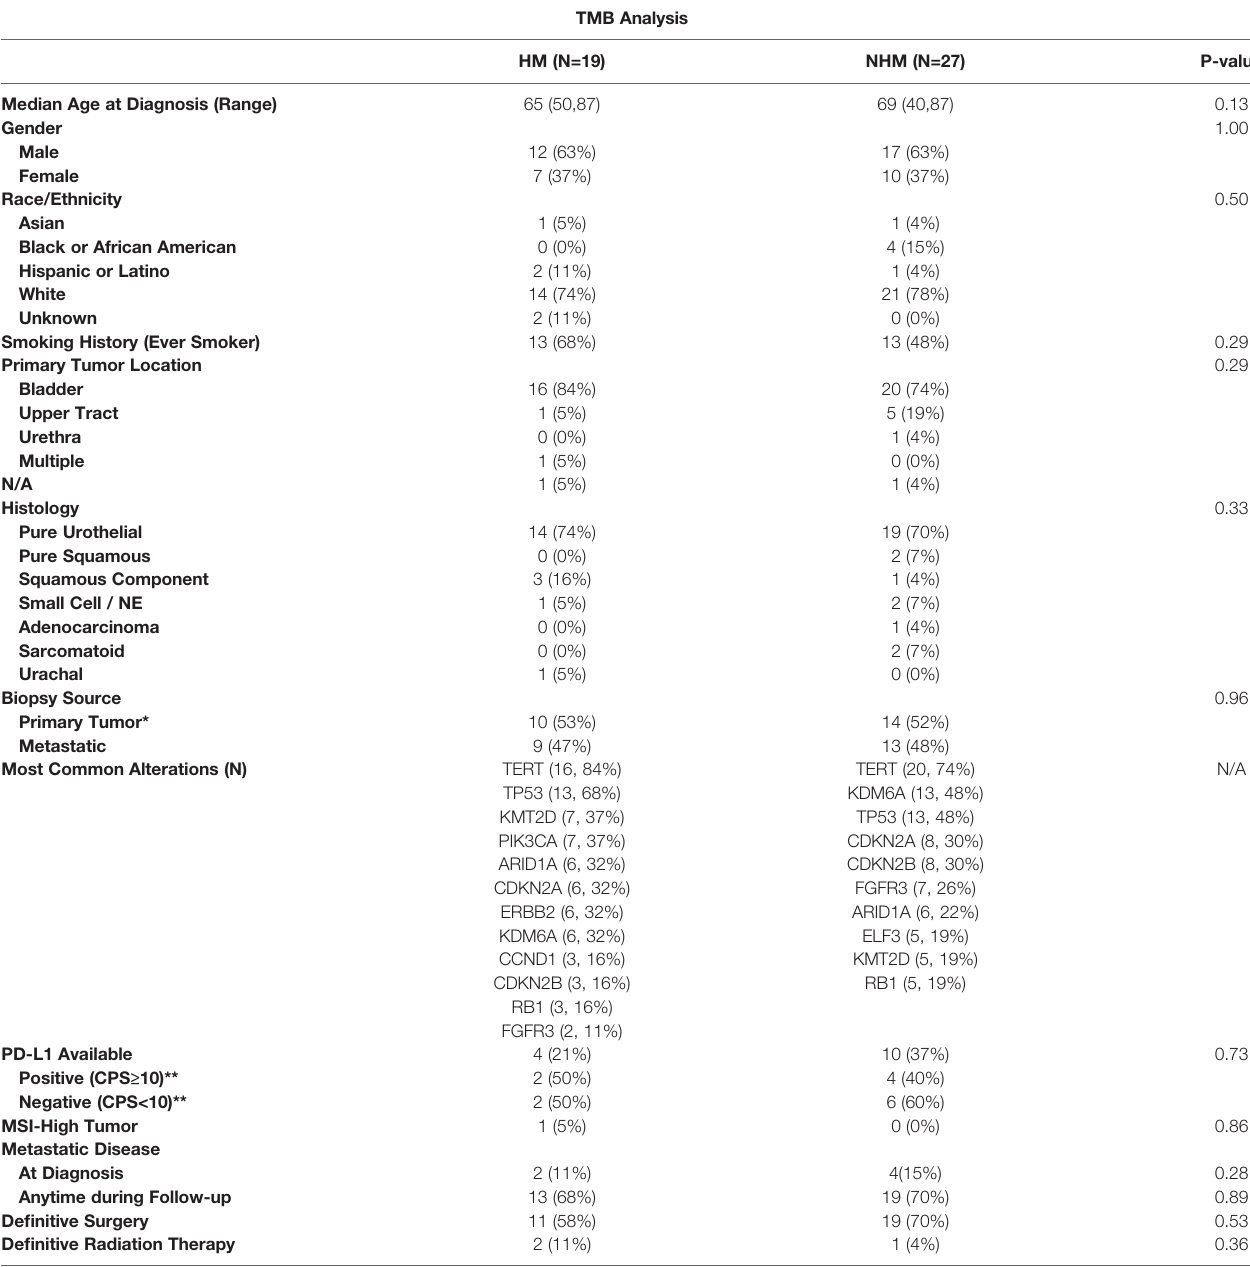
TABLE 1 | Clinical characteristics of patients in the hypermutated and non-hypermutated